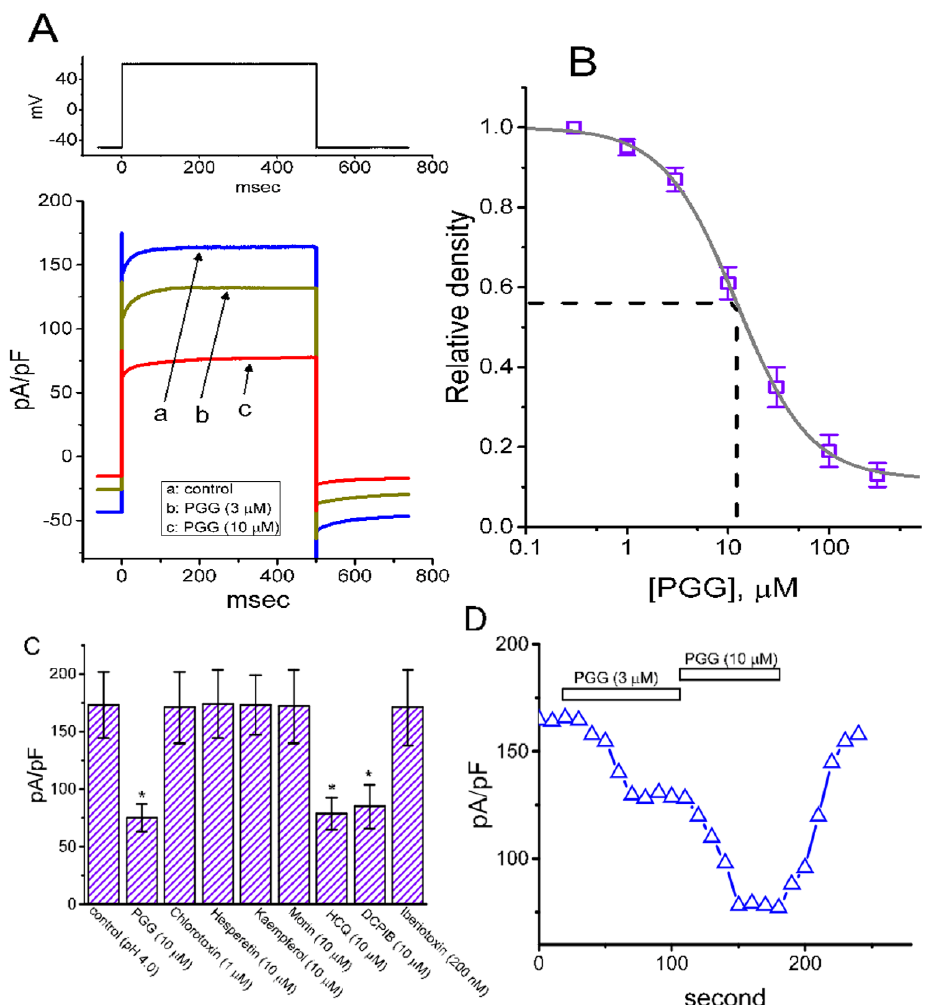
Figure 5. Concentration-dependent inhibitory effect of PGG on I PAC density ( A , B ) and comparisons in effects of PGG, chlorotoxin, hesperetin, kaempferol, morin, hydroxychloroquine and iberiotoxin on